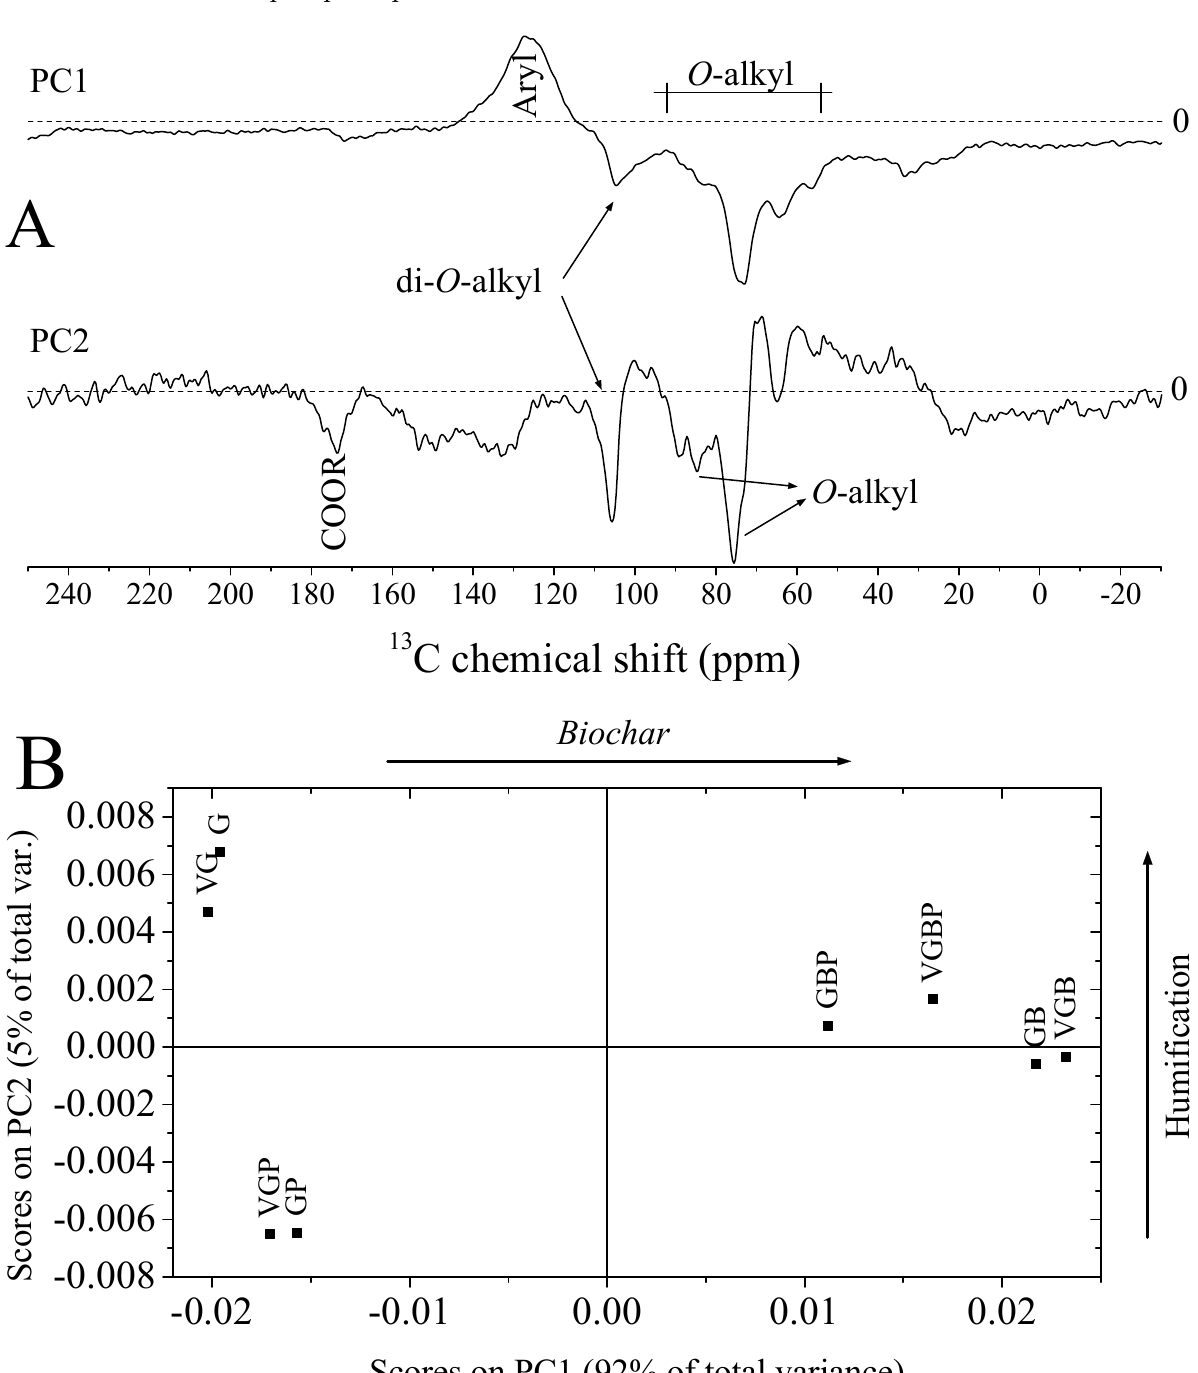
Figure 4. ( A ) PCA loadings obtained from the 13 C NMR spectra. ( B ) PCA scores. G: grass compost; VG: grass vermicompost; GP: grass + phosphate compost; VGP: grass + phosphate vermicompost; GBP: grass + biochar + phosphate compost; VGBP: grass + biochar + phosphate vermicompost.